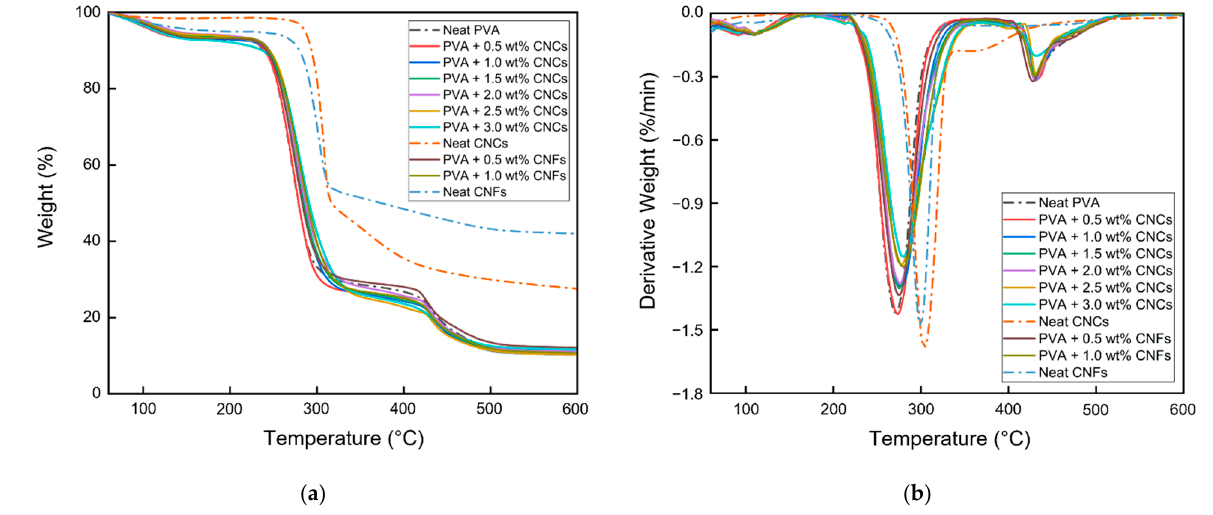
Figure 9. ( a ) TGA and ( b ) DTG profiles of the PVA + CNC/CNF nanocomposite films. Table 3. T onset , T offset , T max , and mass loss of the PVA + CNC/CNF nanocomposite films.